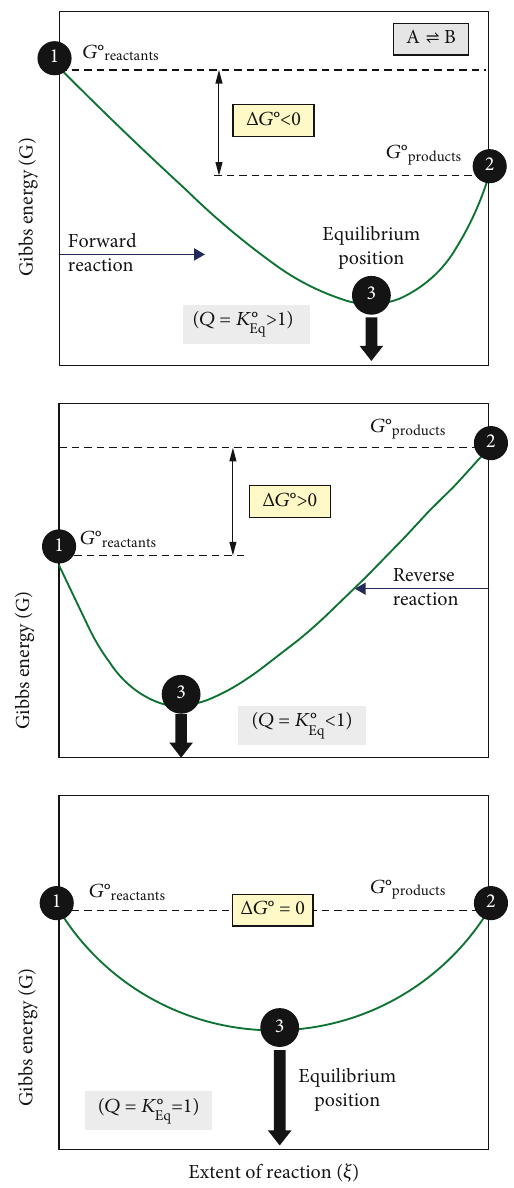
Figure 1: Gibbs energy ( G ) as function of the extent of reaction ( ζ ) for describing Δ G ° (negative, positive, or zero). Adapted from the literature [31] with some modi fi